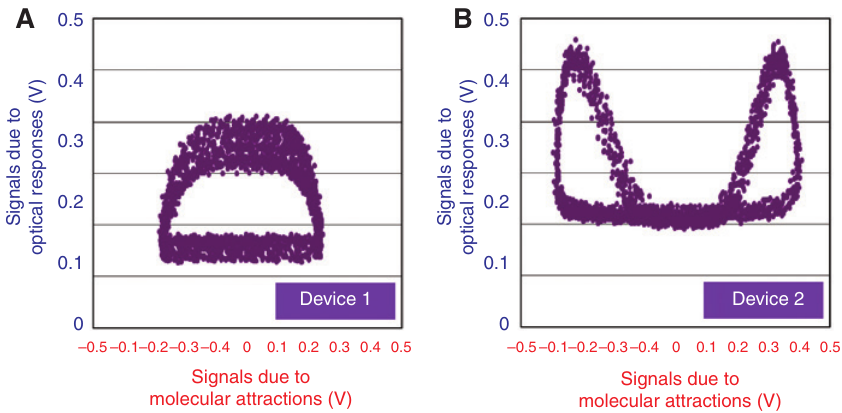
Figure 9: Two-dimensional plots of retrieved signals by using non-scanning nanoretrieval with (A) artifact 1 and (B) artifact 2. Source: Adapted with permission from Springer-Verlag: Appl. Phys. A